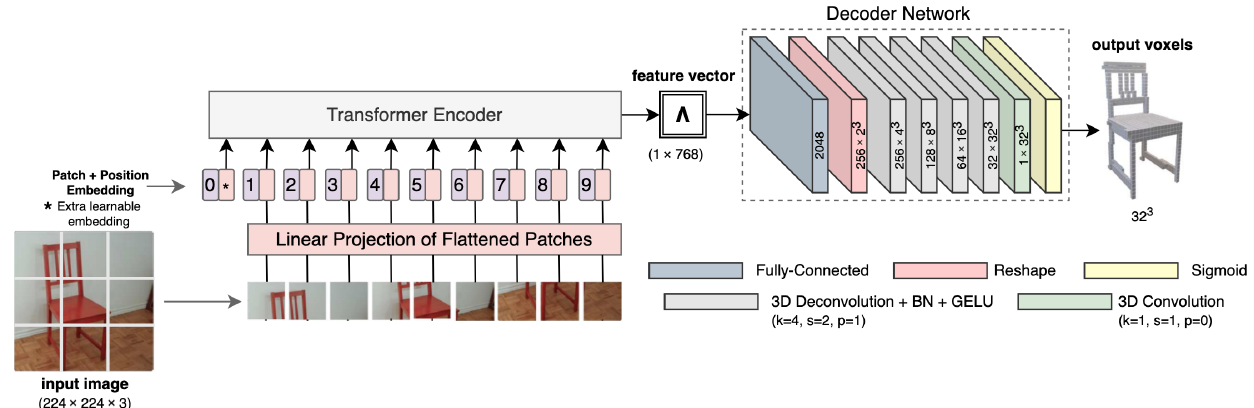
Figure 10. 3D-VRVT takes one image as input and uses a Vision Transformer encoder to extract a feature vector. This is then fed to a decoder that outputs the voxel representation of the